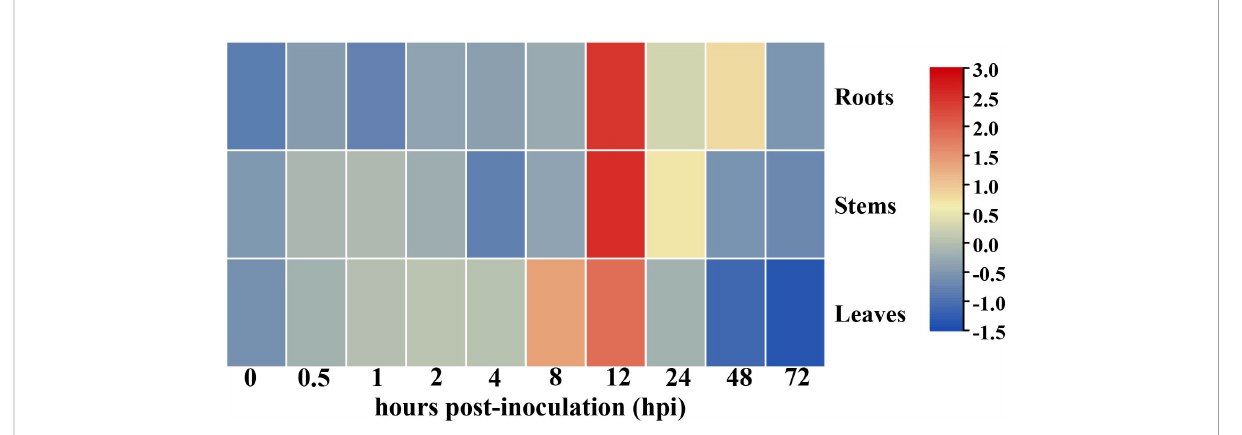
FIGURE 2 Expression of GhHSFA4a in cotton inoculated with V. dahliae . RNA was extracted from roots, stems, and leaves of 3-week-old seedings at 0, 0.5, 1, 2, 4, 8, 12, 24, 48, and 72 hours post-inoculation (hpi) with V. dahliae . Relative transcript levels were quanti fi ed using qRT-PCR with UBQ as the internal reference gene. The experiments were performed in duplicate using different RNA samples for the template.